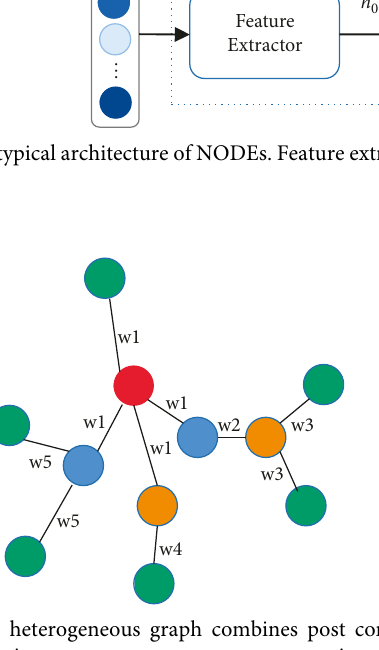
Figure 2: The heterogeneous graph combines post content and rumor propagation structure as rumor representation. The edge between two nodes is the content representations built with the word frequency and the inverse post frequency. The red point is the original post. The nodes sharing the same father node have the same rumor content